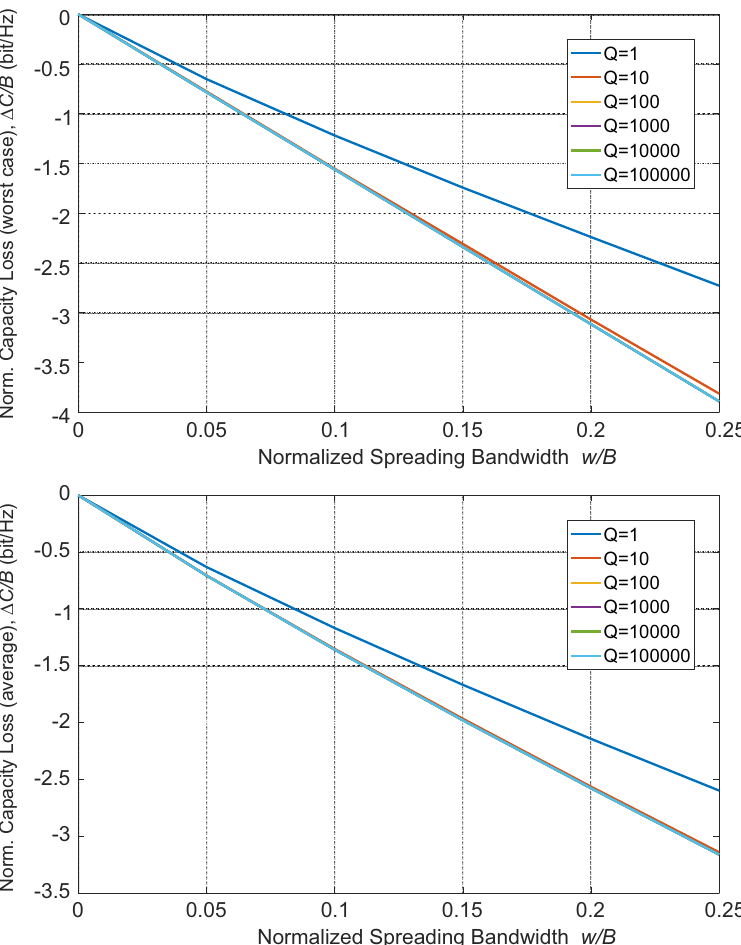
Figure 8. Worst case and average normalized capacity loss over different resonant frequencies f R versus SS-modulation depth δ ranging from 0 (no SS) to 25% for different values of the resonant coupling quality factor Q under constant coupling